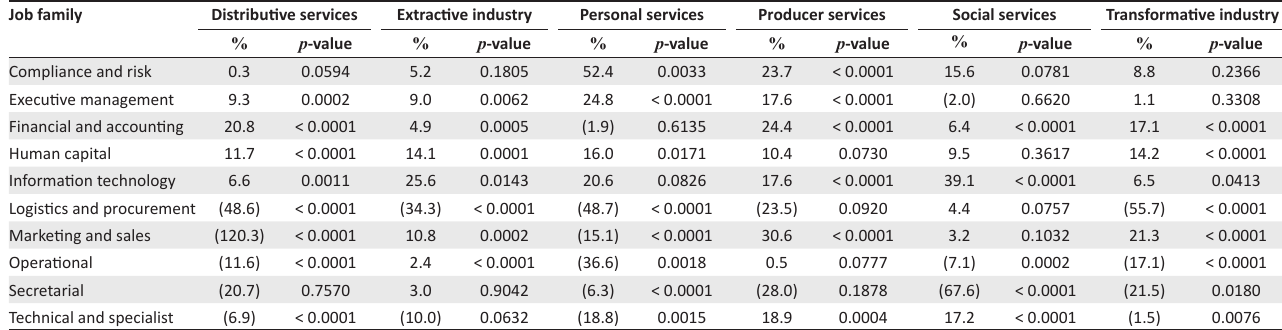
TABLE 4: Occupational gender pay gap in the industry. Job